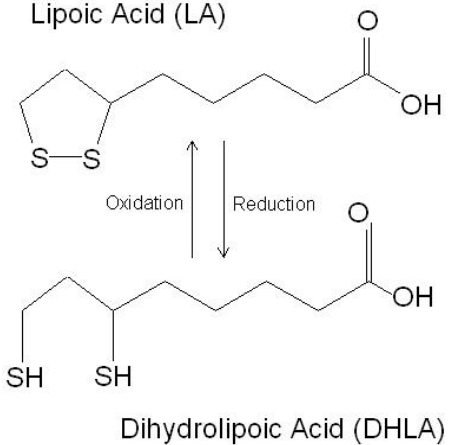
Figure 1. The chemical structure of lipoic acid and its active metabolite dihydrolipoic acid (https://www.robertbarrington.net/alpha-lipoic-acid-antioxidant/; posted on Jan 3th, 2014 by Robert Barrington (accessed on 5 February 2021)).